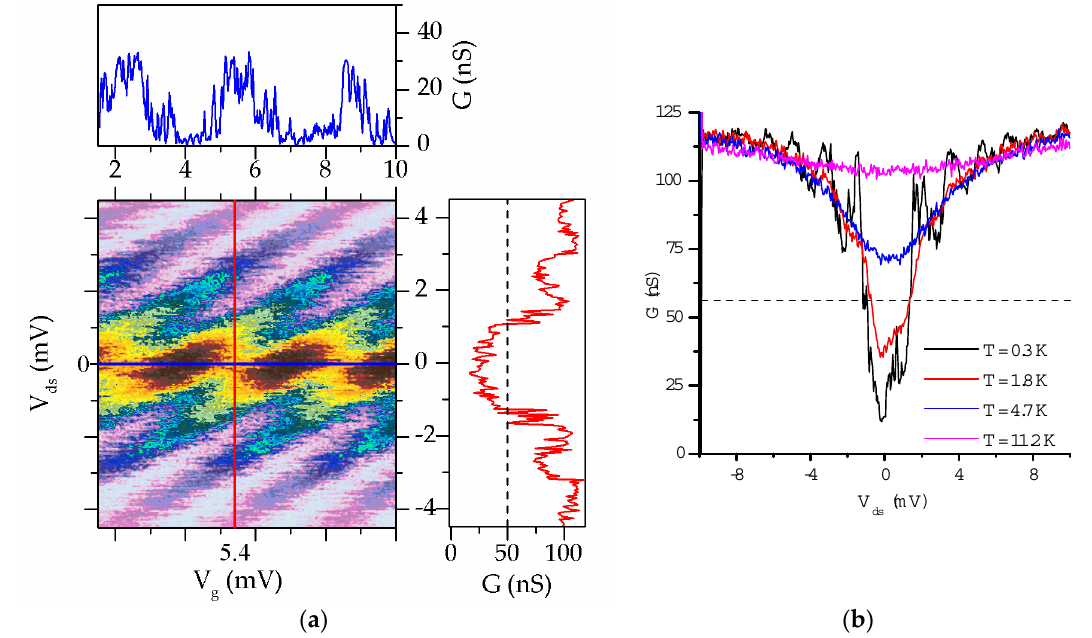
Figure 7. Electrical characteristics for O 3 ‐ based Pt ‐ Al 2 O 3 ‐ Pt SET after anneal in forming gas at 90 °C for 1 h: ( a ) diamond plot at 0.3 K with V g ( V ds = 0 mV, blue) and V ds ( V g = 5.4 mV, red) cross sections; and ( b ) G ( V ds ) dependence of SET conductance measured in the peak of Coulomb blockade at several temperatures. The peaks of CBOs are below G 0 /2 (black dashed line), contrary to Coulomb blockade theory for metal ‐ insulator ‐ metal SETs.